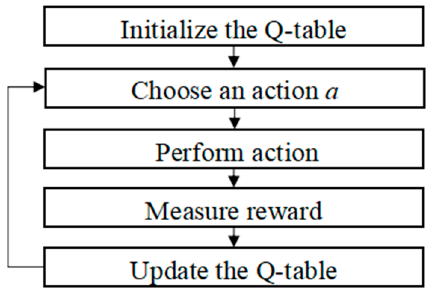
Figure 1. Structure diagram of the Q-Learning.